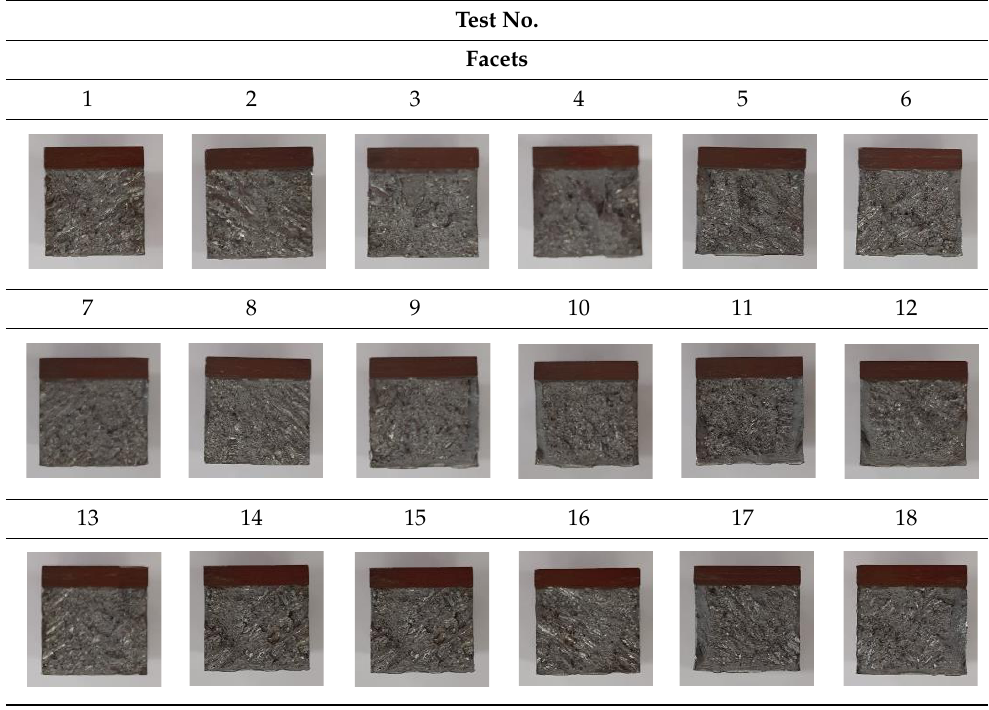
Figure 5. Typical fracture surface according to ductile and brittle. ( a )Ductile fracture. ( b )Brittle fracture.